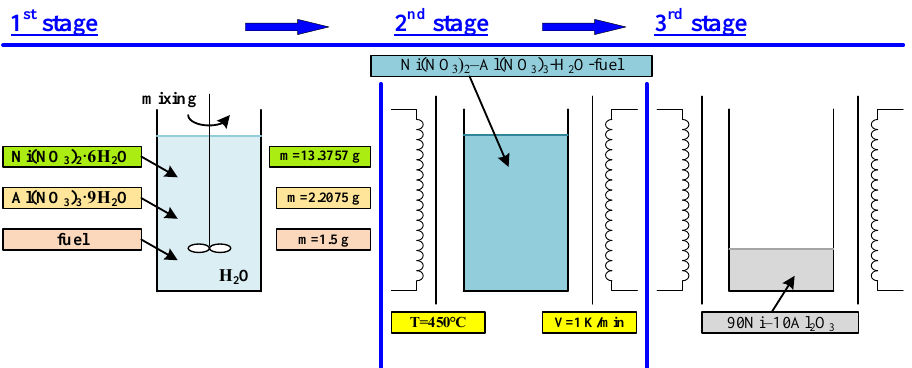
Figure 1. Preparation technique of Ni/Al 2 O 3 catalyst using solution combustion synthesis.